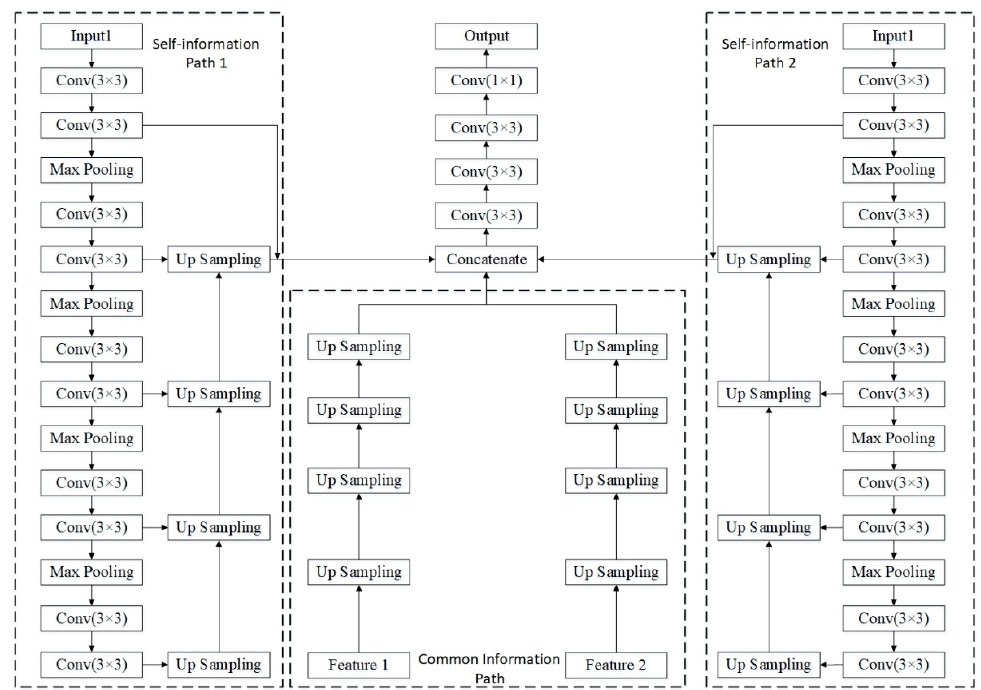
Figure 5. The proposed information fusion based multi-source data segmentation structure. The proposed structure contains two self-information extraction path and a common information extraction path. The weights of these paths are copied from well-trained the common information extraction structure and self-information extraction structure, as mentioned in Figures 3 and 4.